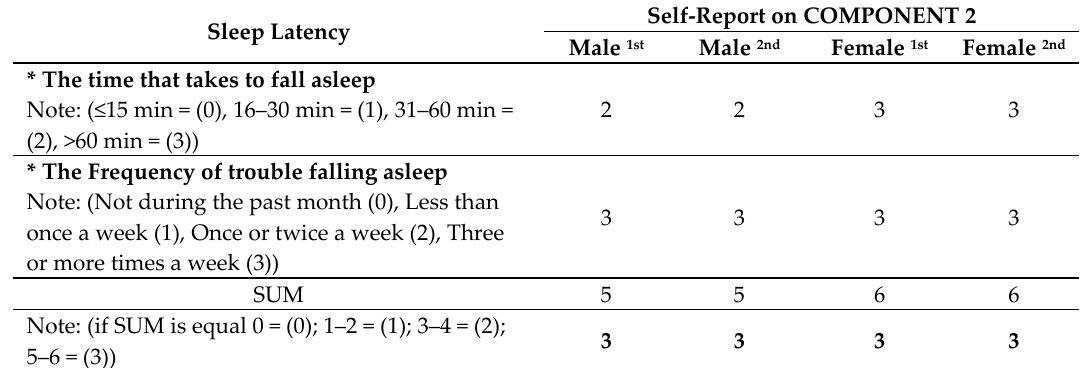
Table 2. Component 2 of the PSQI on the 4 flight attendants.